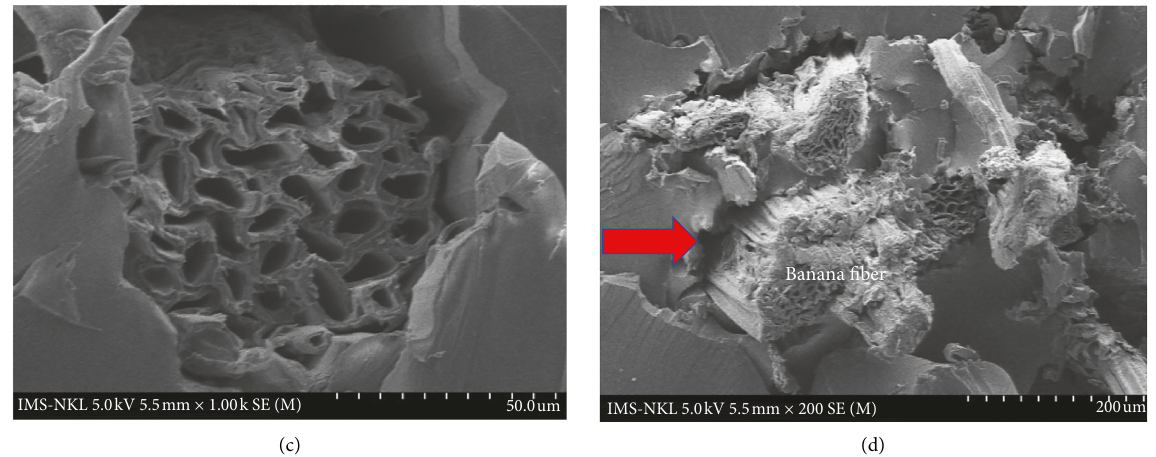
Figure 4: SEM of PLA/banana fiber composites: (a) – 10 wt.%, (b, c) – 20 wt.%, (d) -30 wt.% banana fiber.